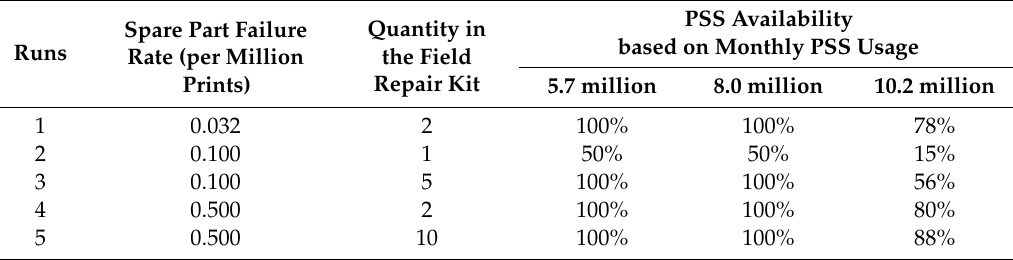
Table 2. Partial results of deterministic PSS simulation.